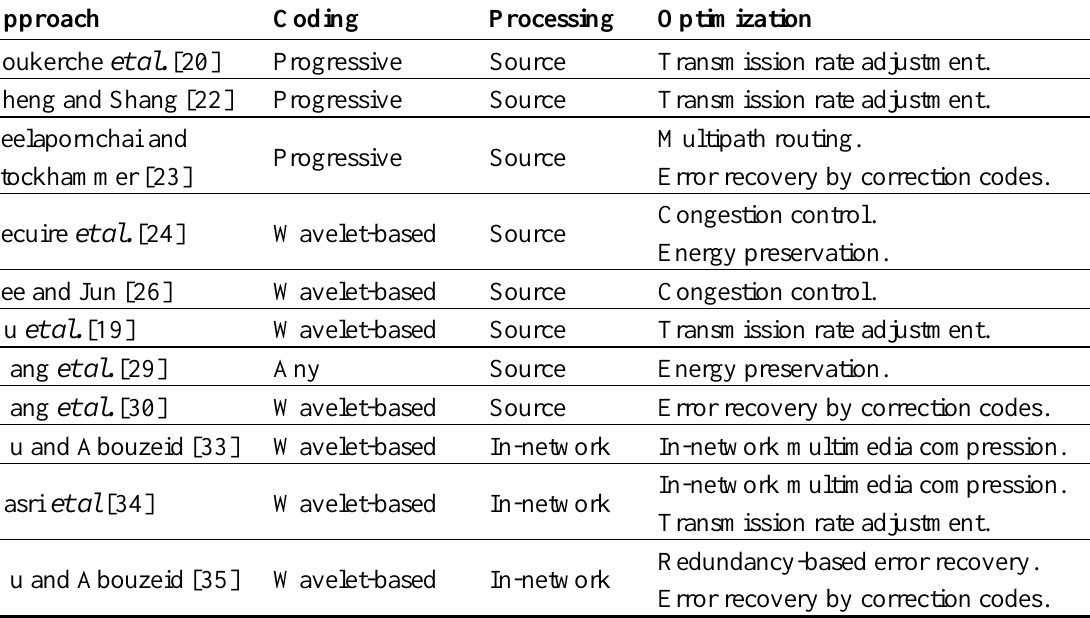
Table 1. Image-based cross-layer